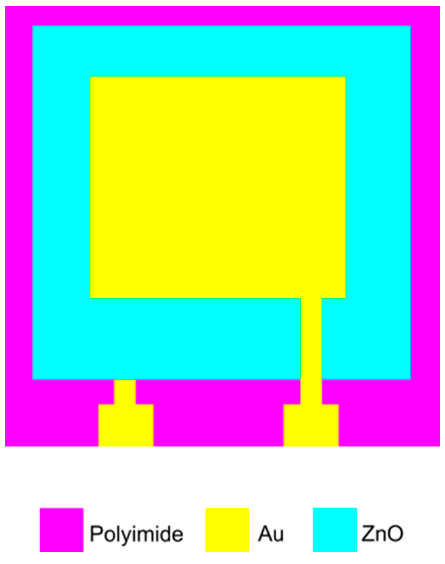
Figure 5. Sketch of the main parts composing the PPT structure in the CPE configuration—Top view.